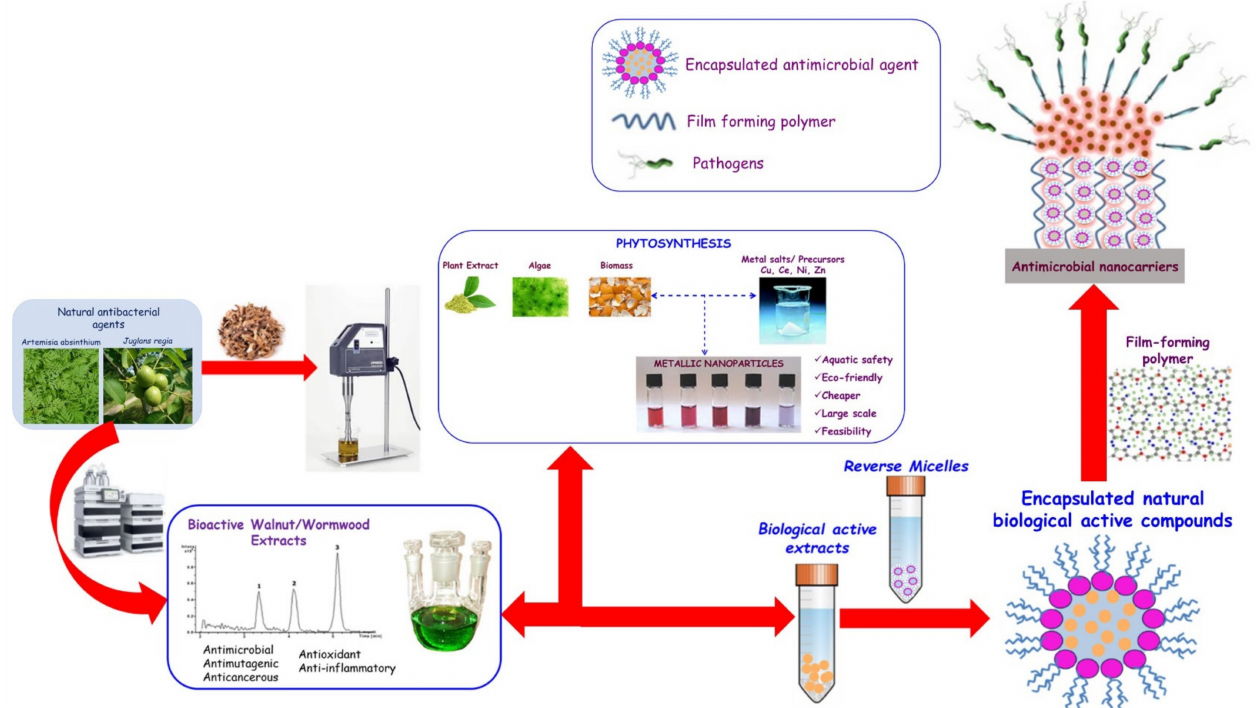
Figure 12. Encapsulation of antimicrobial bioactive compounds in reverse